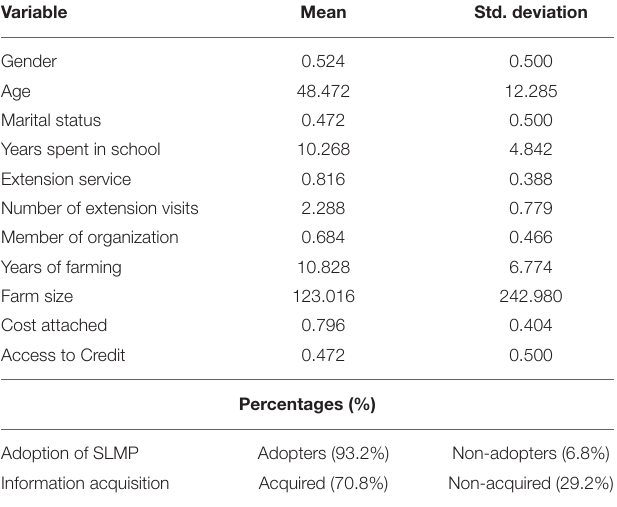
TABLE 3 | Summary statistics of the variables